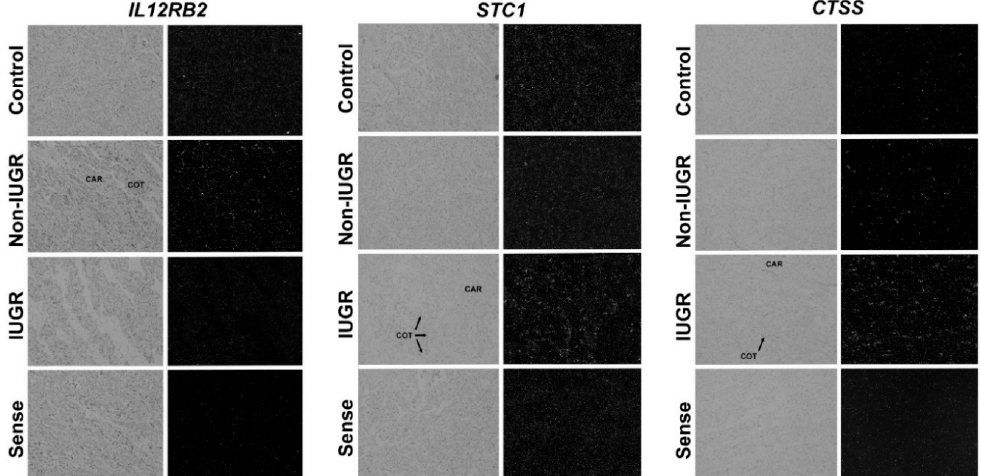
Figure 2. Select microarray-identified genes downregulated in NR non-IUGR placentomes were validated using qPCR. ( A ) GATM, SLC44A4, STC1 and SULF2 mRNA expression was greater ( p < 0.05) in NR IUGR compared to NR non-IUGR placentomes. ( B ) CADM1, CTSS, and DPYD mRNA expression was greater ( p < 0.05) in NR IUGR than NR non-IUGR placentomes. ( C ) CD86 and CXCL10 mRNA expression was greater ( p < 0.05) in NR IUGR than NR non-IUGR placentomes. Mean gene expression values from control fed ewes have been included for informative comparisons only and were not included in the statistical analysis. Legend: RU, relative units. * Indicates p < 0.05 between NR Non-IUGR and NR IUGR placentomes.